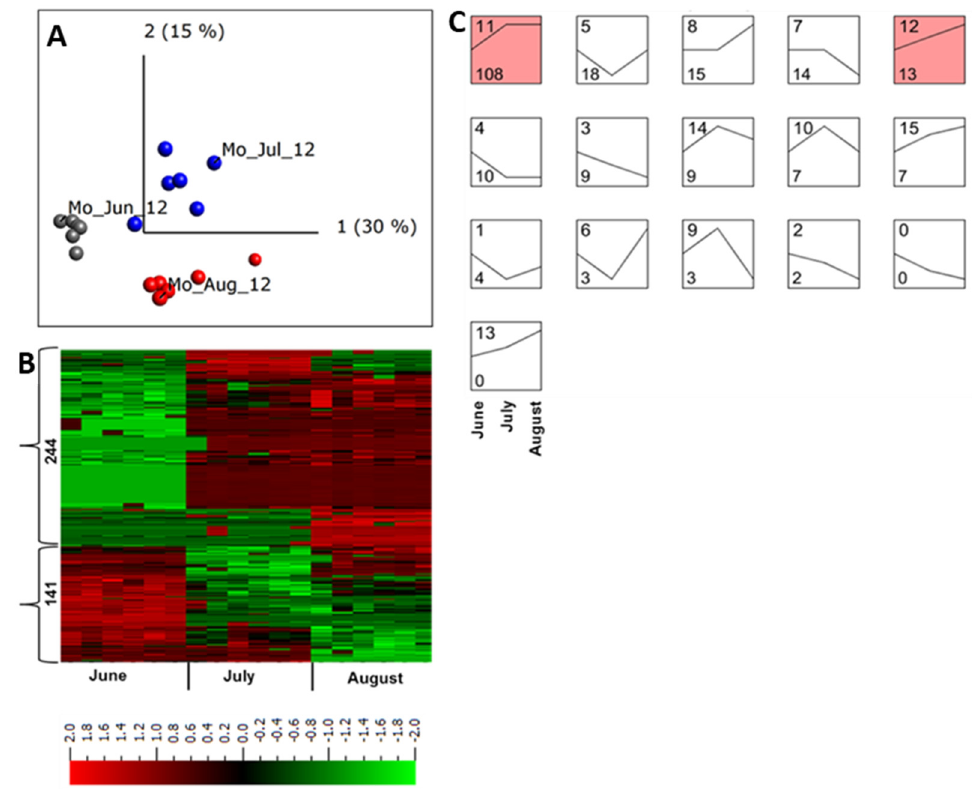
Figure 3. Quantitative analysis of apoplastic proteome samples isolated from potato cultivar Bintje grown in Mosslunda in 2012. ( A ) Unsupervised principal component analysis plot of all the samples collected in June (Mo_Jun_12), July (Mo_Jul_12), and August (Mo_Jul_12). Each circle represents one biological replicate. ( B ) Heat maps and the number of peptides up- and down-regulated in plants grown under field conditions in Mosslunda. We performed a multi-group comparison with false discovery rate < 0.001 (according to the Benjamini − Hochberg procedure for determining q ). Heat map of the differentially regulated peptides ( q < 0.001) was sorted using hierarchal clustering and red represents higher abundance (Fold change, log2). ( C ) STEM clustering analysis of apoplastic peptides in June, July, August of 2012 in Mosslunda. Proteins that were significantly ( q ≤ 0.001) increased or decreased in at least one of the months across the growing season were used for the STEM clustering analysis. Top left of each box is the profile number and bottom left of each box indicates the number of peptides that fit the defined abundance pattern in June, July, and August. The STEM analysis identified 16 profiles, of which profiles 11 and 12 contains statistically significant number of proteins ( p < 0.05).